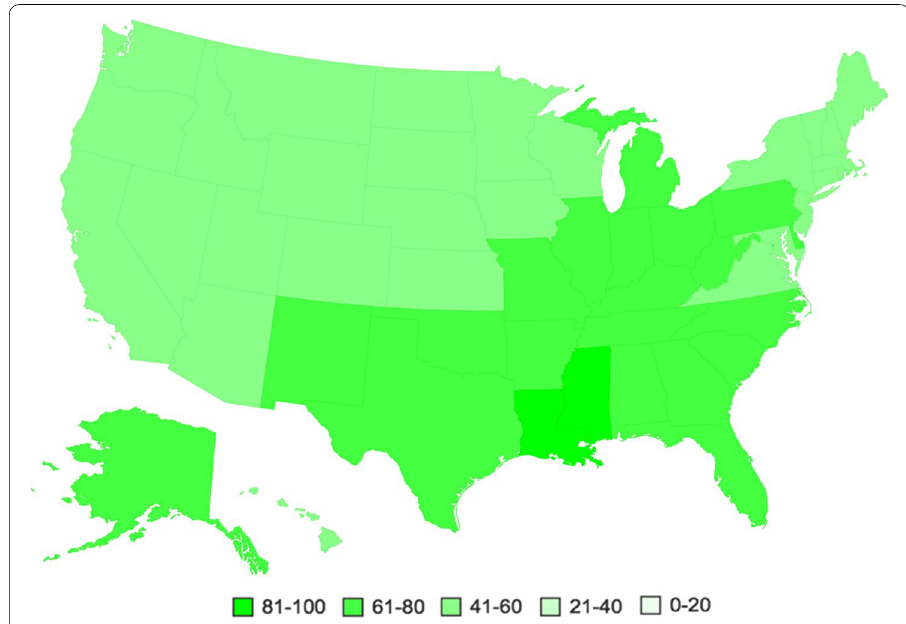
Fig. 3 Heat map of the online interest in the term ‘Gonorrhea’ by State